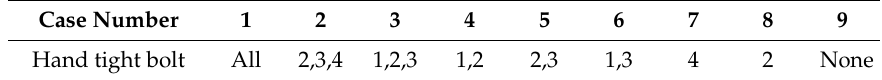
Table 1. Bolt loosening cases for the four-bolt